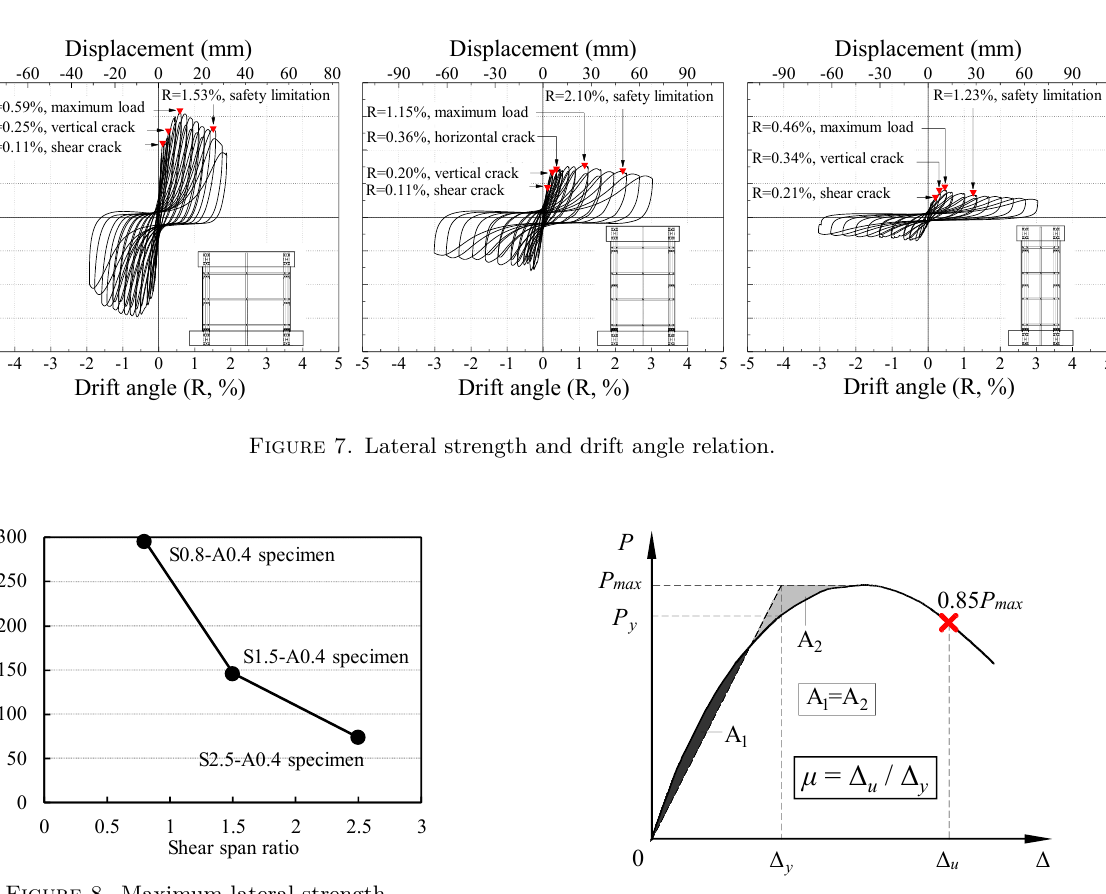
Figure 10. Characteristic points of P